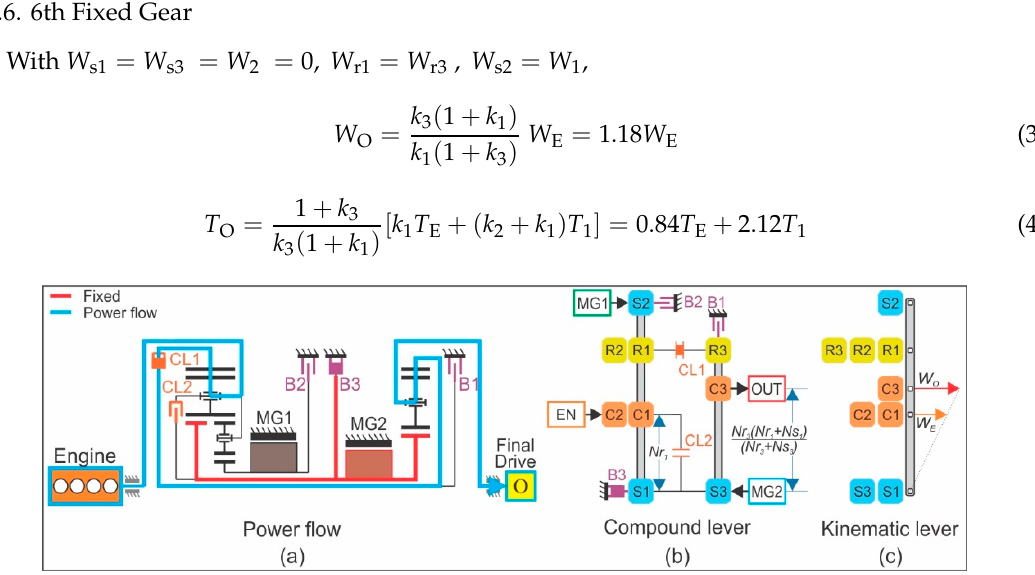
Figure 24. Fifth fixed gear.